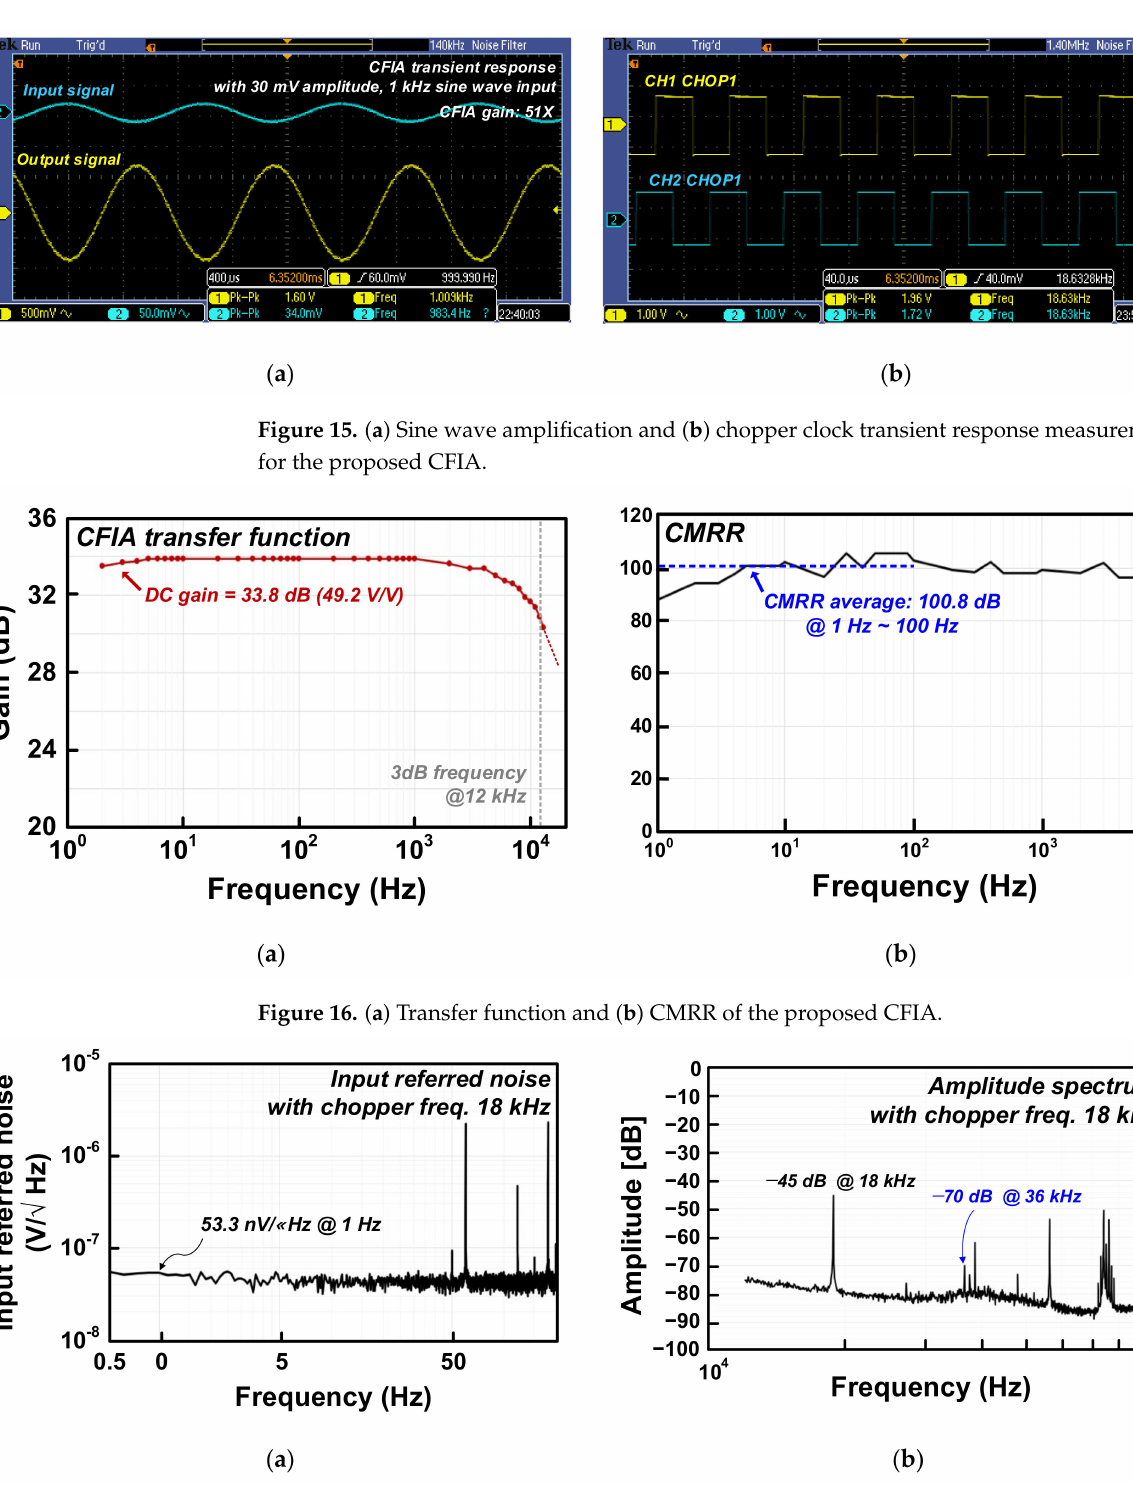
Figure 17. Experimental ( a ) input-referred noise and ( b ) amplitude spectrum of 1 kHz 10 mV sine input for IMD tone